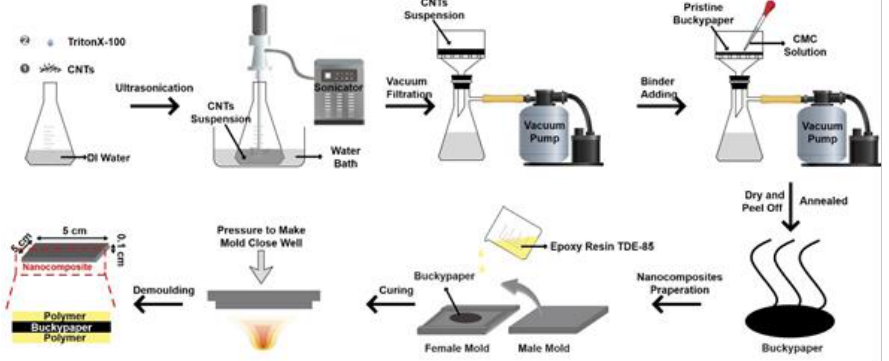
Figure 1. A schematic illustration of the fabrication of CMC/buckypaper/epoxy nanocomposites.